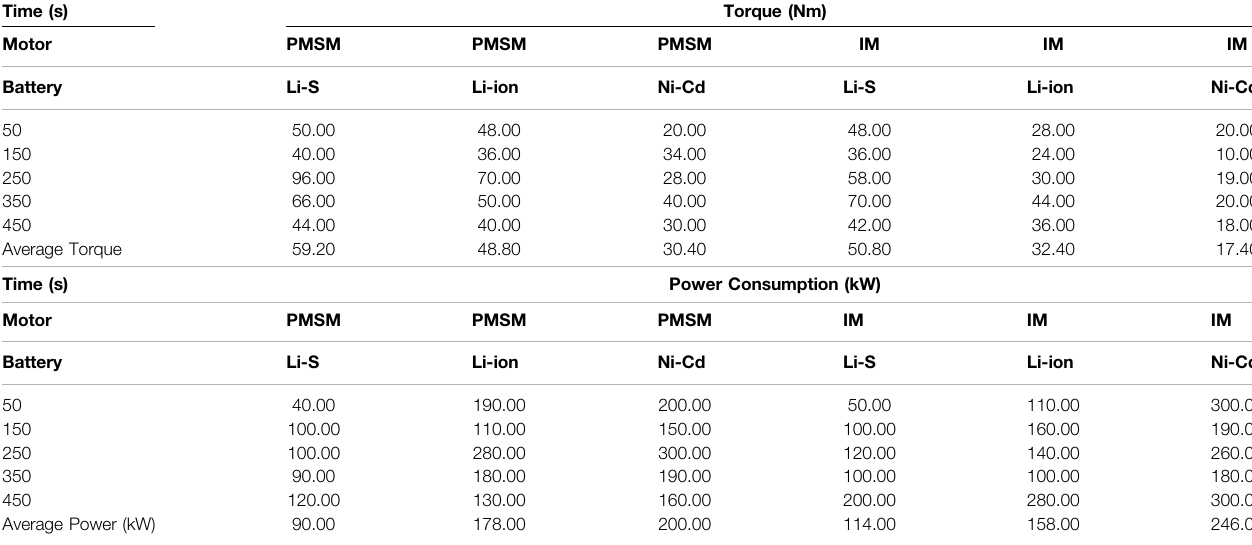
TABLE 6 | Average torque and power produced from different combinations of batteries and motors. Time